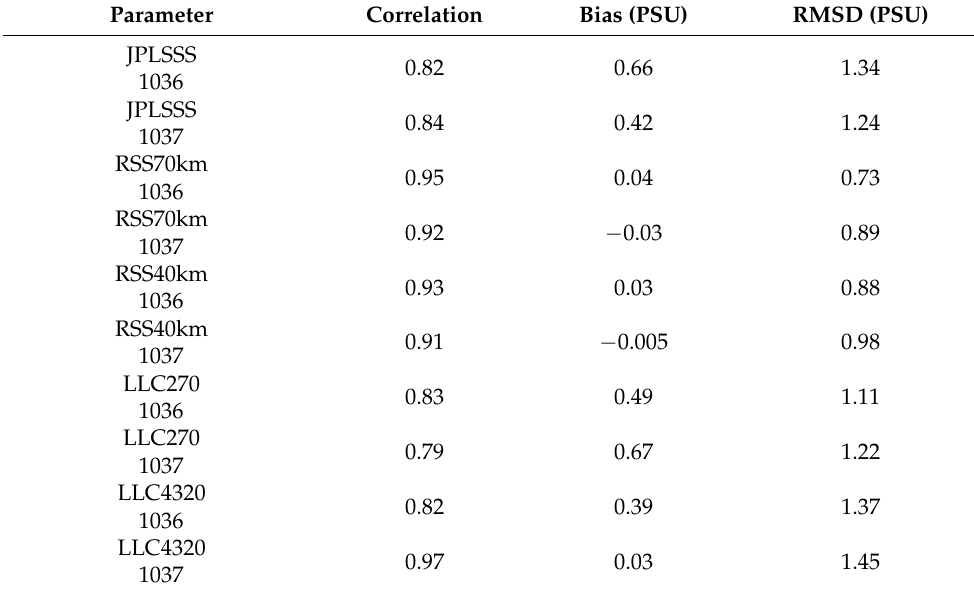
Table 1. Statistics for Saildrone/SMAP/model comparisons. Rows correspond to the specific SMAP product and model versus Saildrone comparison for each specific deployment. Parameter Correlation Bias (PSU) RMSD